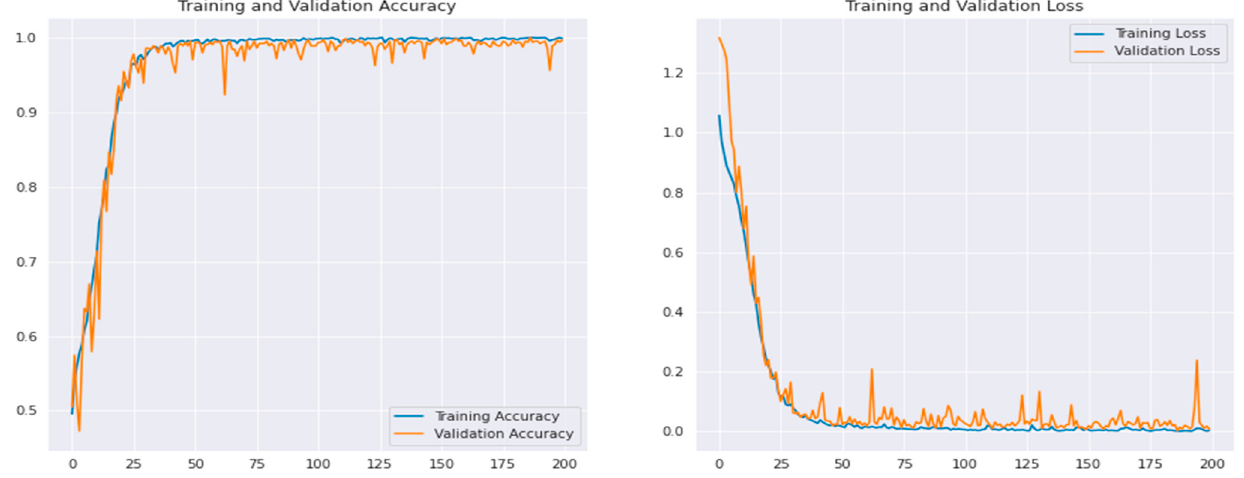
Figure 6. Training and validation loss of proposed CAD-ALZ system on the selected datasets.